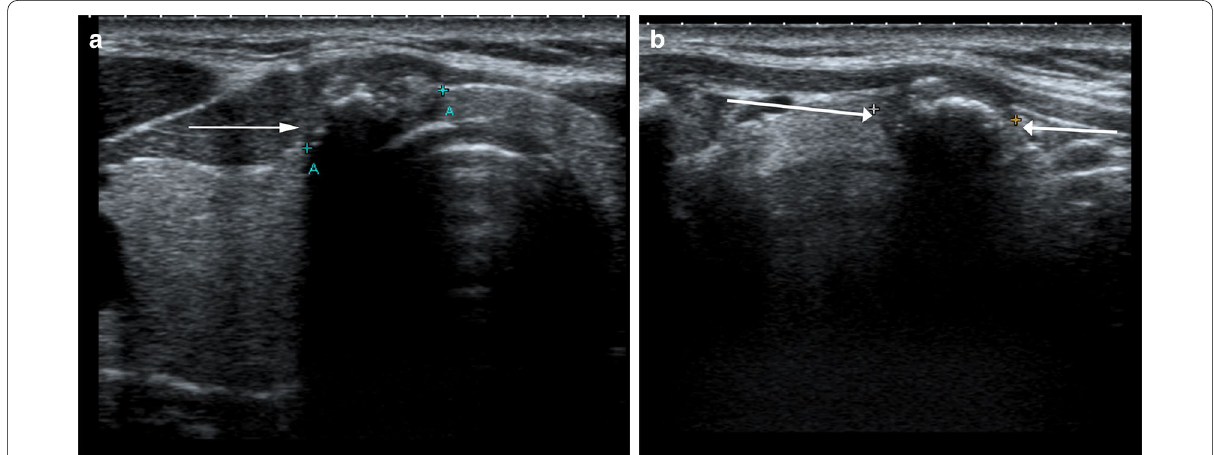
Fig. 6 61-Year-old male patient. a (Transverse image) and b (sagittal image) show the PTC (arrow, within calipers) in right isthmus of thyroid gland. The nodule shows dystrophic coarse calcification with strong acoustic shadowing which limits assessment of posterior margin of the nodule. Not only does this preclude accurate measurement of the nodule at baseline or at follow-up, the angle of contact of nodule with trachea also cannot be assessed. In addition, the nodule shows extrathyroid extension anteriorly into strap muscles with loss of perithyroid echogenic line anteriorly. The patient was not offered AS and underwent surgery